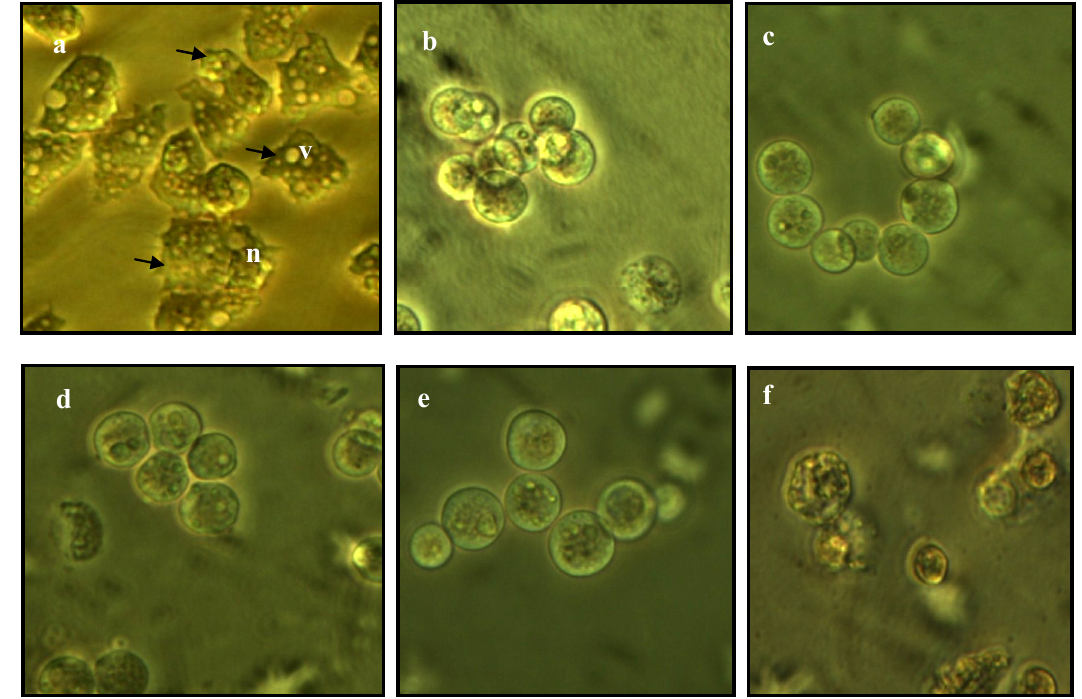
Figure 2. Light microscopy of A. polyphaga . ( a ) Untreated cells; ( b ) M1 -treated cells with acanthapodia structures on the cells surface (arrows); ( c ) M2 -treated cells; ( d ) M3 -treated cells; ( e ) M4 -treated cells; ( f ) Chlorhexidine-treated cells. Nucleus ( n ); vacuoles ( v ). Magnification